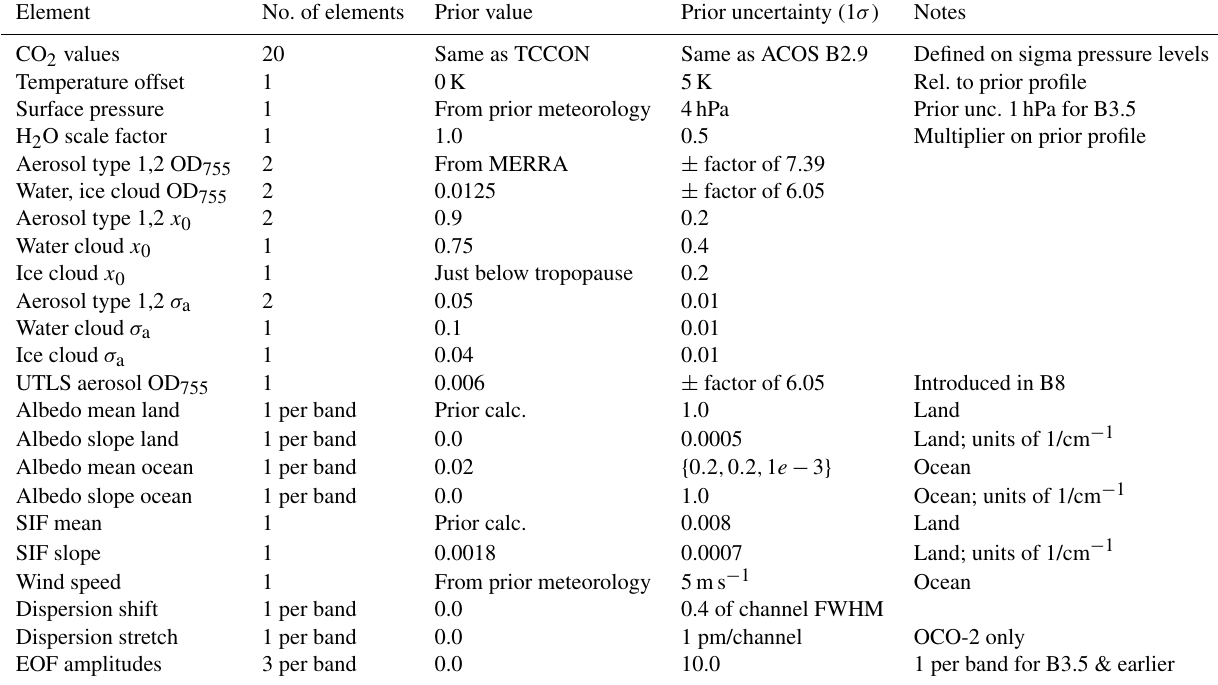
Table 2. General setup of the ACOS state vector.